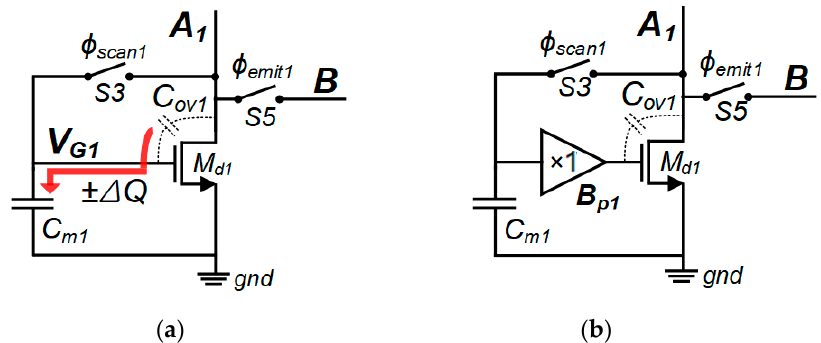
Figure 4. Buffer addition to improve data sampling accuracy: (a) pixel design without a buffer; (b) pixel design with a buffer.